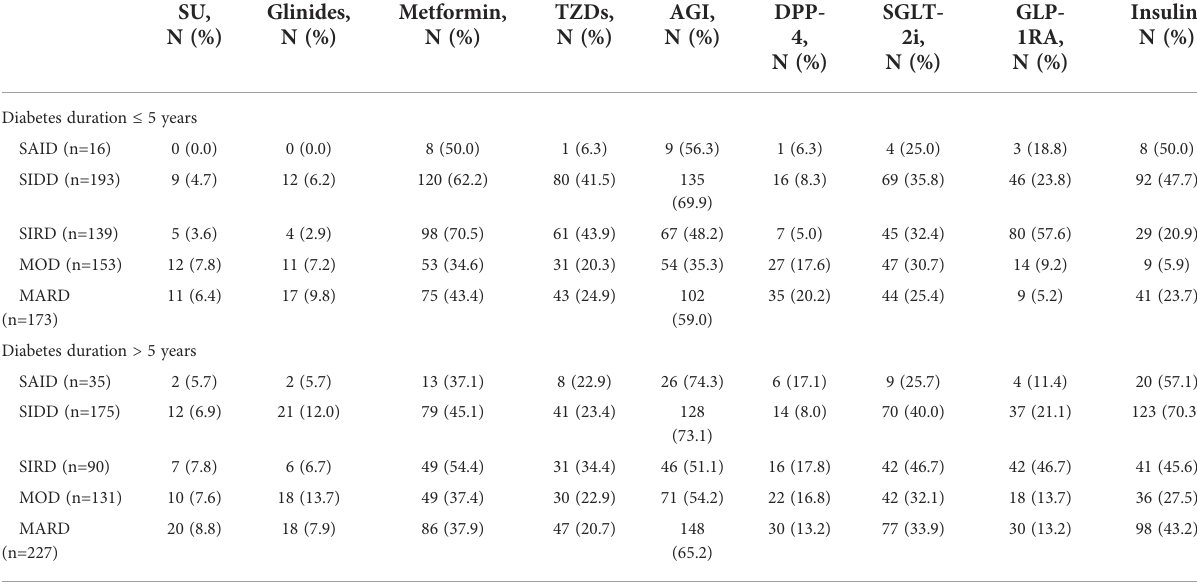
TABLE 4 Characteristics of medication application in diabetes